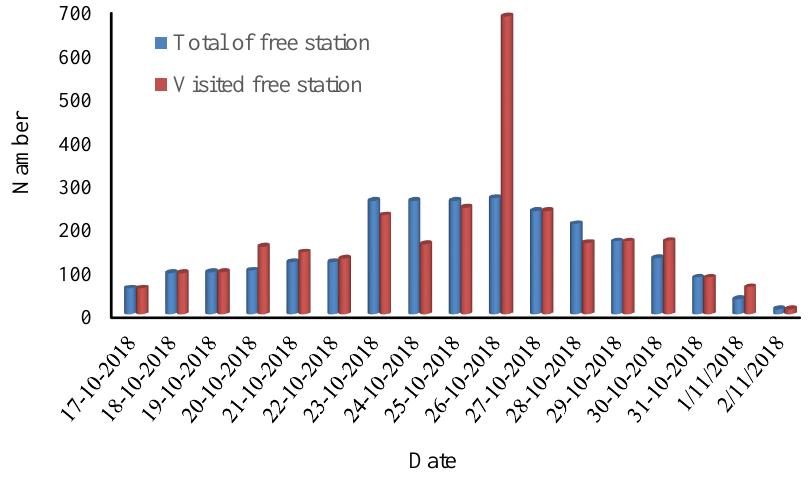
Fig. 2. Number of free service stations and number of visits per day